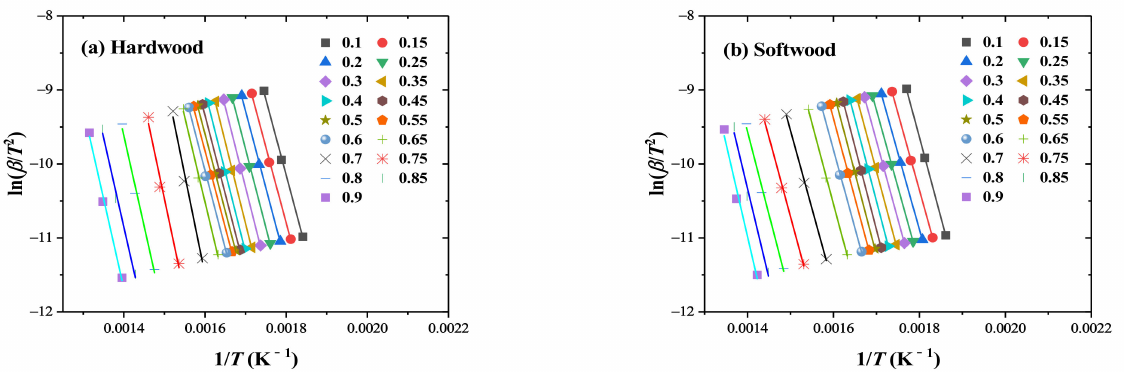
Figure 4. The plots of the KAS method at different conversion degrees for ( a ) hardwood and ( b ) softwood.